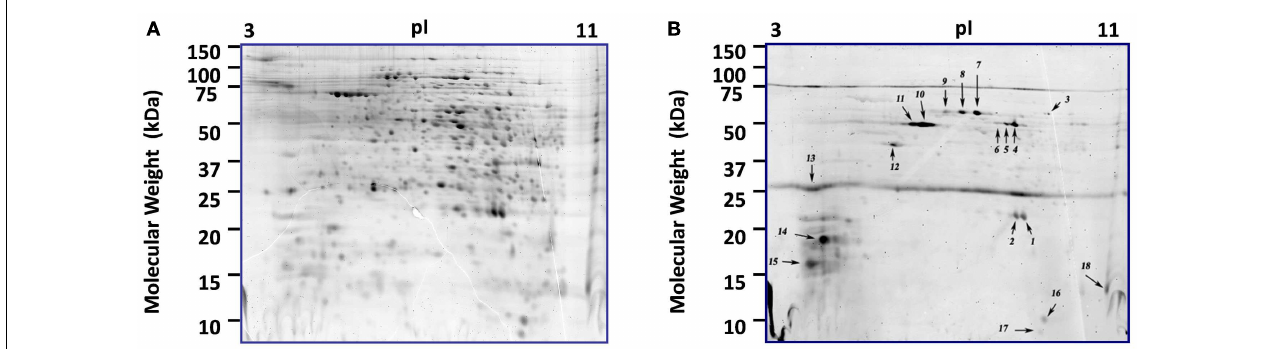
specific stain, ProQ diamond. Each of the numbered spots was picked and the proteins were identified by LCMS and results are shown inTable S4 in Supplementary Material.